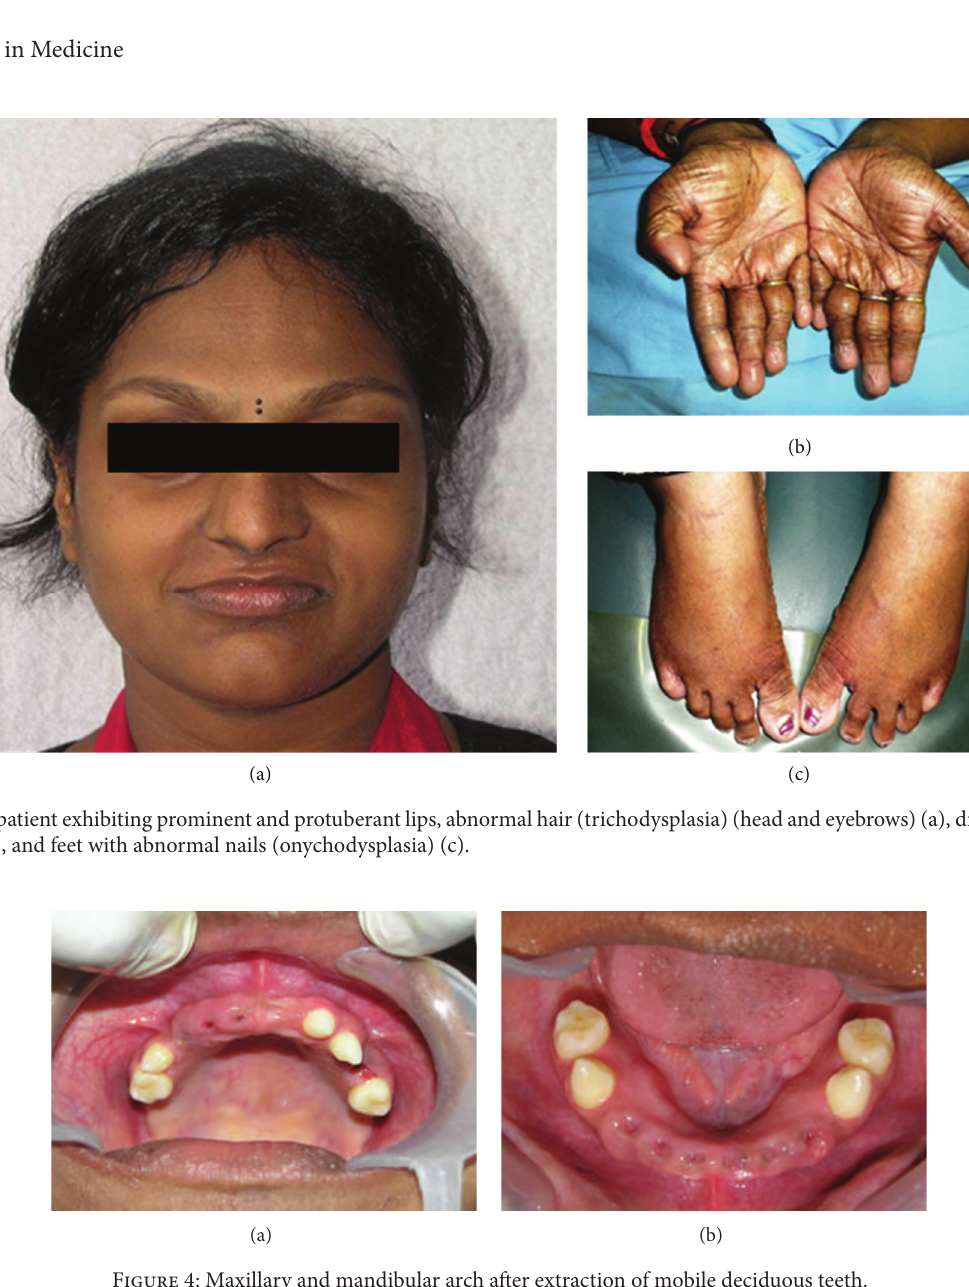
Figure 4: Maxillary and mandibular arch after extraction of mobile deciduous teeth.